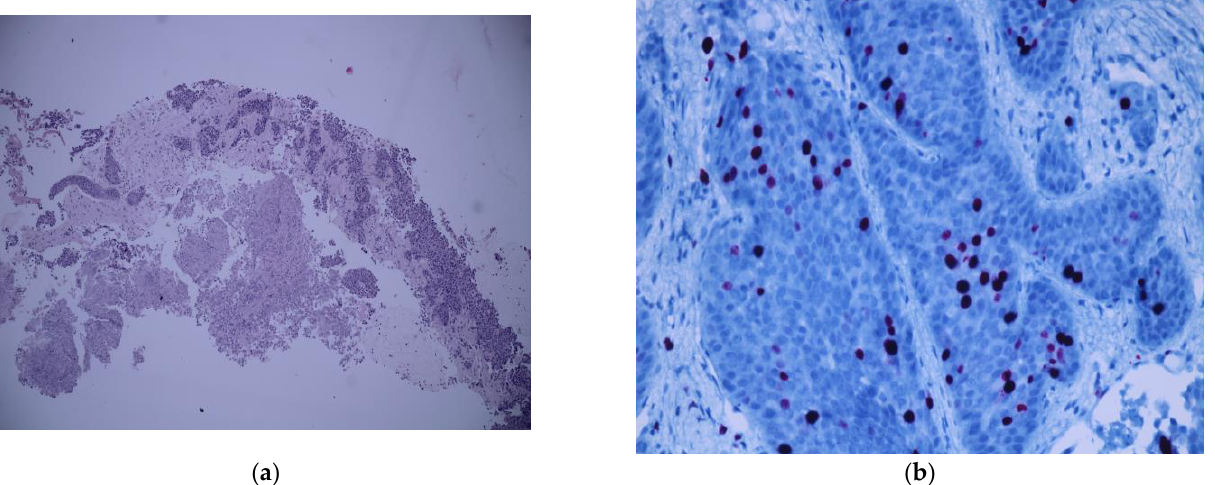
Figure 7. ( a ) Hematoxylin and eosin staining showing numerous small monomorphic cells with